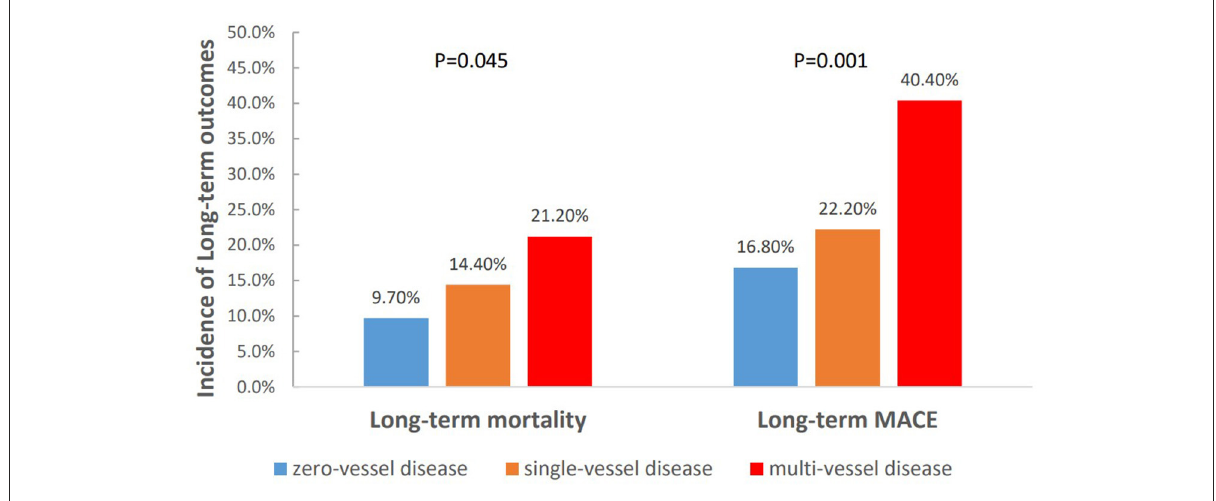
FIGURE4 The incidence of long-term outcomes classified by the number of identified stenosed coronary vessels.